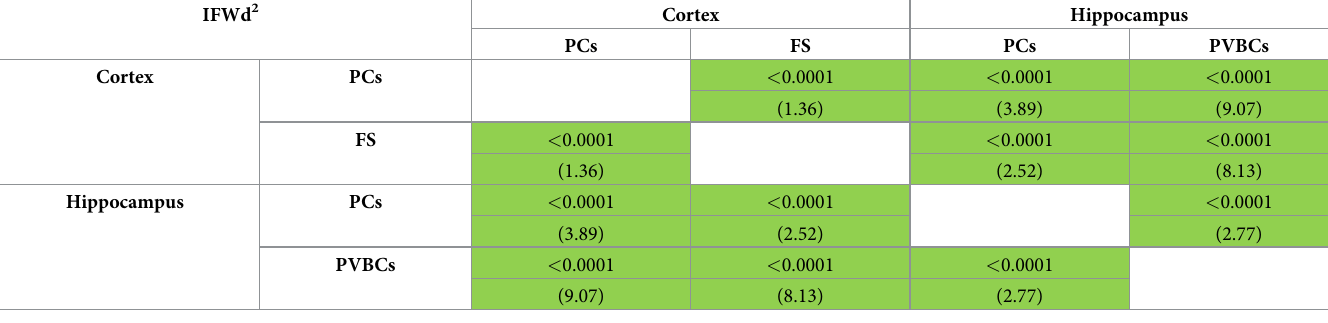
Table 5. Two-tailed p-value from the t-score between the IFWd 2 values from different neuron types, and Cohen’s d effect size (in parentheses). IFWd 2